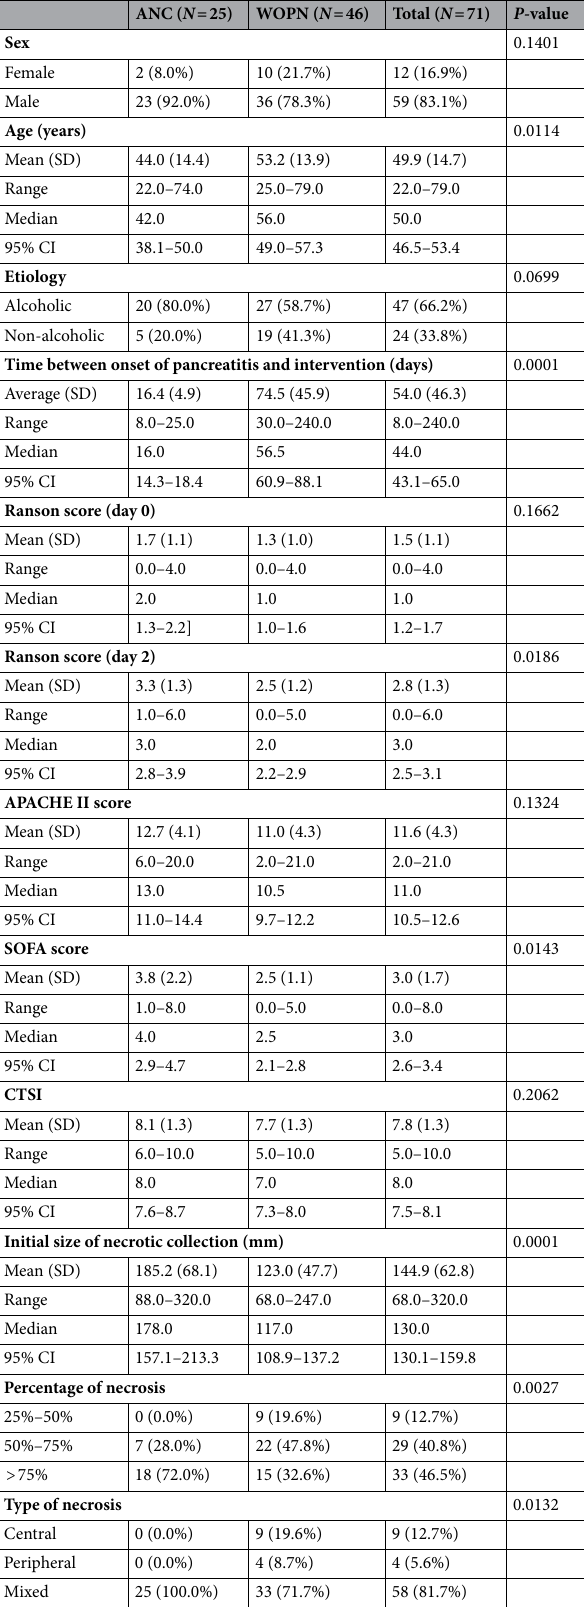
Table 1. Detailed characteristics of patients of the two groups. SD, standard deviation; CI, confidence interval; ANC, acute necrotic collection; WOPN, walled-off pancreatic